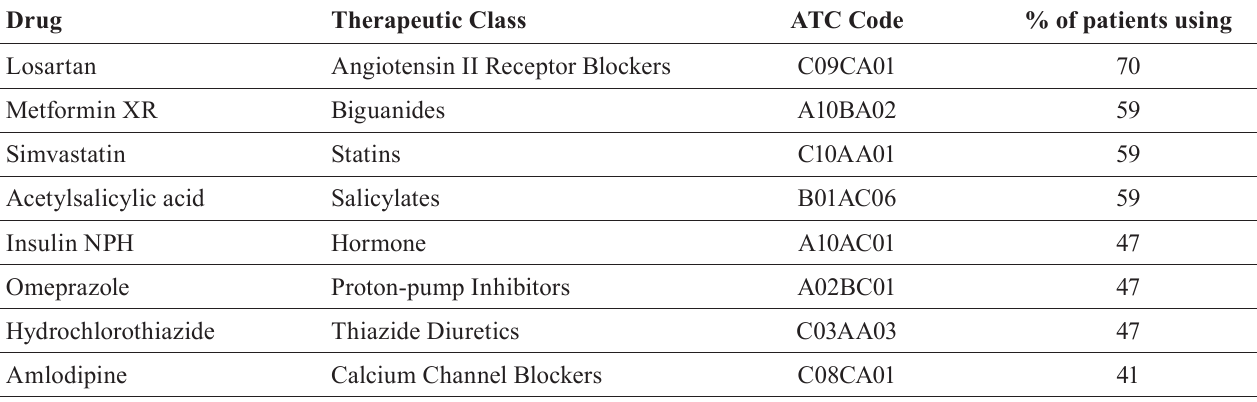
TABLE II - Most prescribed drugs for study patients Drug Therapeutic Class ATC